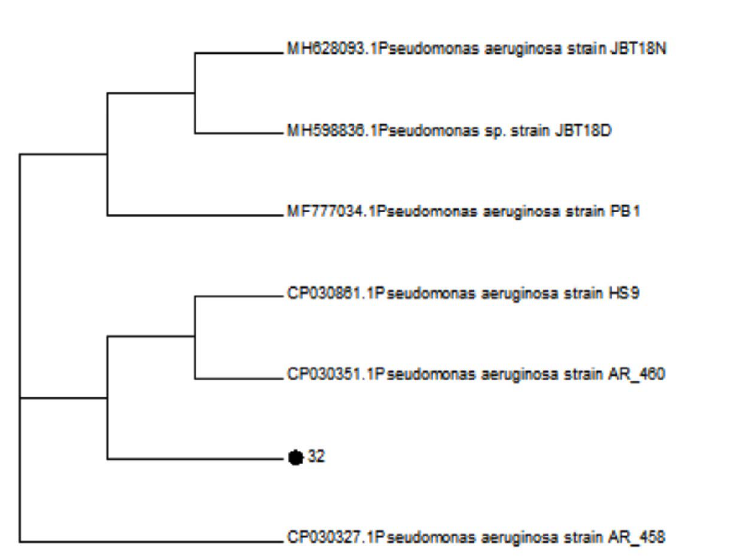
Fig. 7. Phylogram of Pseudomonas aeruginosa LC425424 (31)